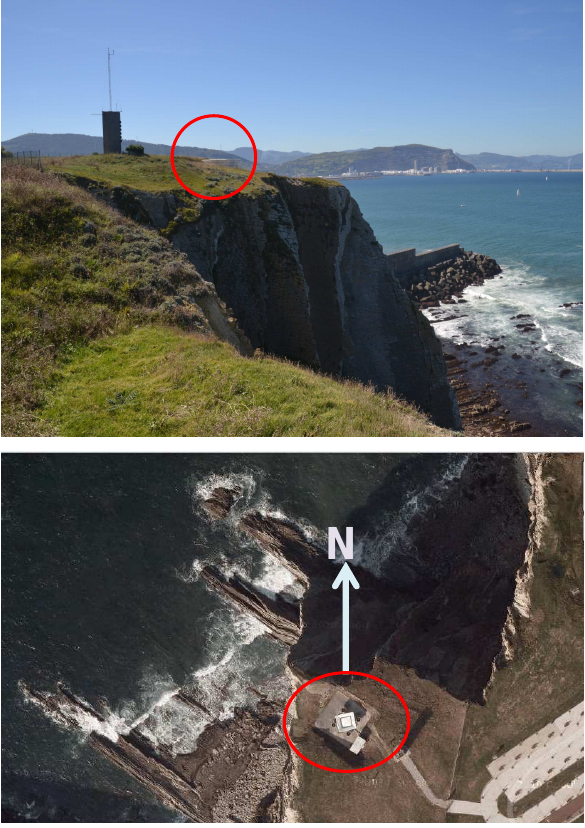
Fig. 1. Geographical location of the Punta Galea wind profiler. Red ellipse indicates the exact location of the site. In top panel, the topography of surrounding area is visualized. Bottom panel, the ground plan of the site is represented and the coastline orientation over North direction can be observed.